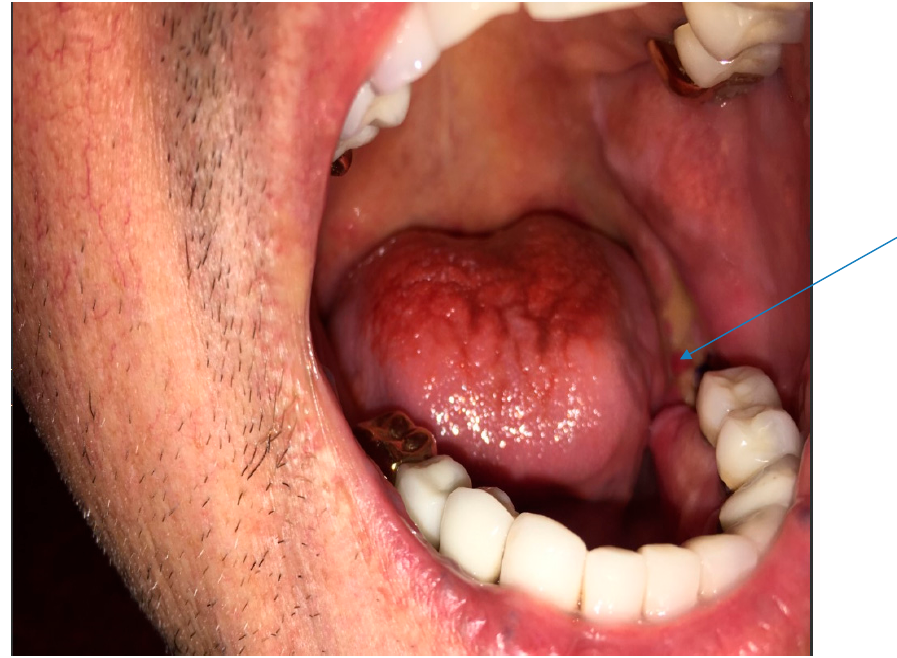
Figure 1. Photograph of the open mouth with arrow pointed at exposed bone around teeth #18 and